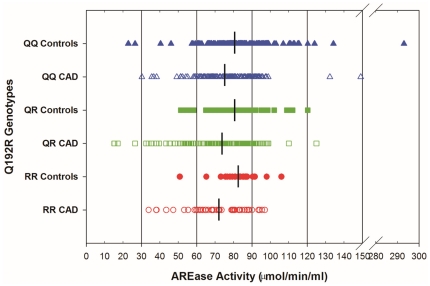
Individual data point for AREase activity in Controls and CAD patients for each PON1 Q192R genotype.Medians are indicated by crossbars.